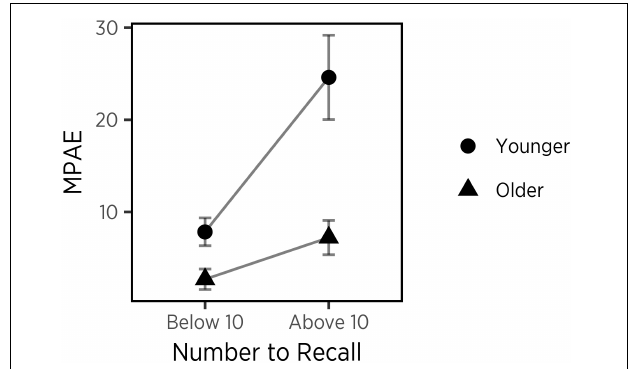
FIGURE 3 | Relation between the magnitude of the number to be recalled and error in recall performance, for younger (circles) and older (triangles) children. Error bars represent standard